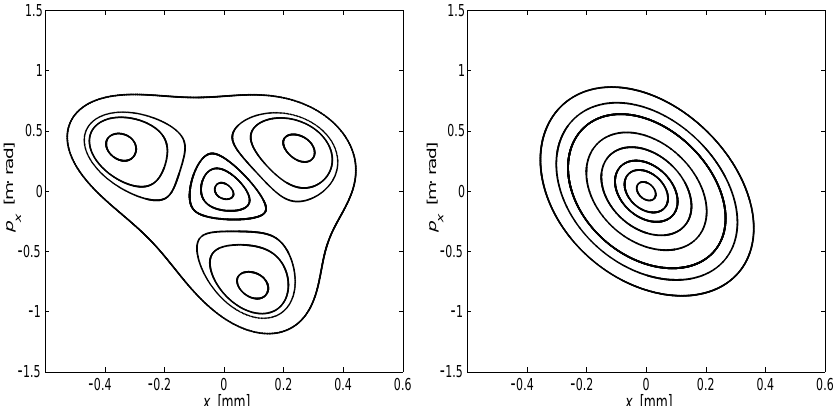
FIG. 15. Horizontal phase space of the lattice plotted at the observation point. Lattices are tuned to n (cid:120) (cid:173) (cid:49)(cid:52)(cid:46)(cid:51)(cid:51)(cid:51)(cid:56) and n (cid:121) = 8.15. The left plot shows the phase space with the uncorrected optic. The right plot shows the phase space for the ideal machine.